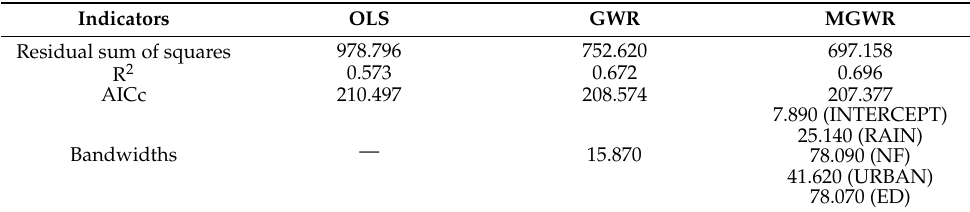
Table 3. Comparison of fit results of low physical fitness regression models for male groups.